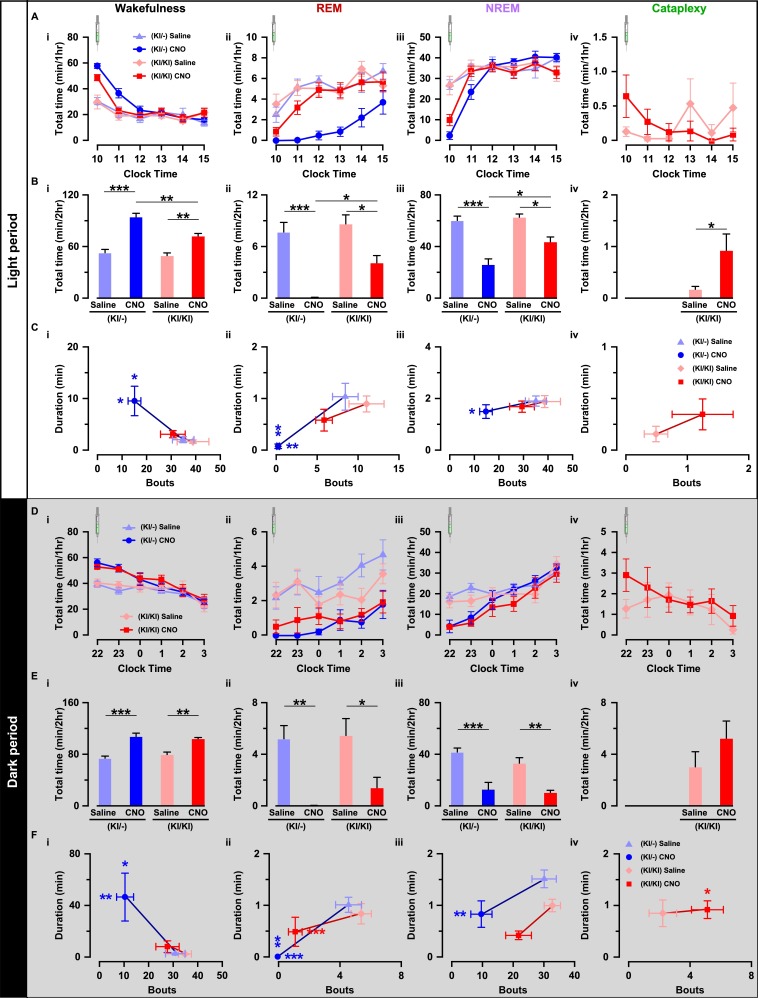
Chemogenetic activation of orexin neurons resulted in altered sleep/wakefulness based on the availability of orexin.(A) Line graph with symbols showing the time spent in wakefulness (i), REM sleep (ii), NREM sleep (iii), and cataplexy (iv) during each hour for the 6 hr following CNO or saline administration during light period. B, Bar graph showing the 2 hr average of the total time spent in wakefulness (i), REM sleep (ii), NREM sleep (iii), and cataplexy (iv) following CNO or saline injection during the light period. C, Scatter plot showing the averaged bout and duration in wakefulness (i), REM sleep (ii), NREM sleep (iii), and cataplexy (iv). The data in D-F are shown similar to the representation in A-C, respectively, recorded during the dark period (OF (KI/-): n = 9 mice and OF (KI/KI): n = 8 mice). Data represent the mean ± SEM in both the line and bar graph. The p values were determined by either two-way ANOVA followed by a post-hoc Bonferroni test or paired student’s t-test (cataplexy).10.7554/eLife.44927.018Figure 7—source data 1.Source data for Figure 7A, B, C, E and F.